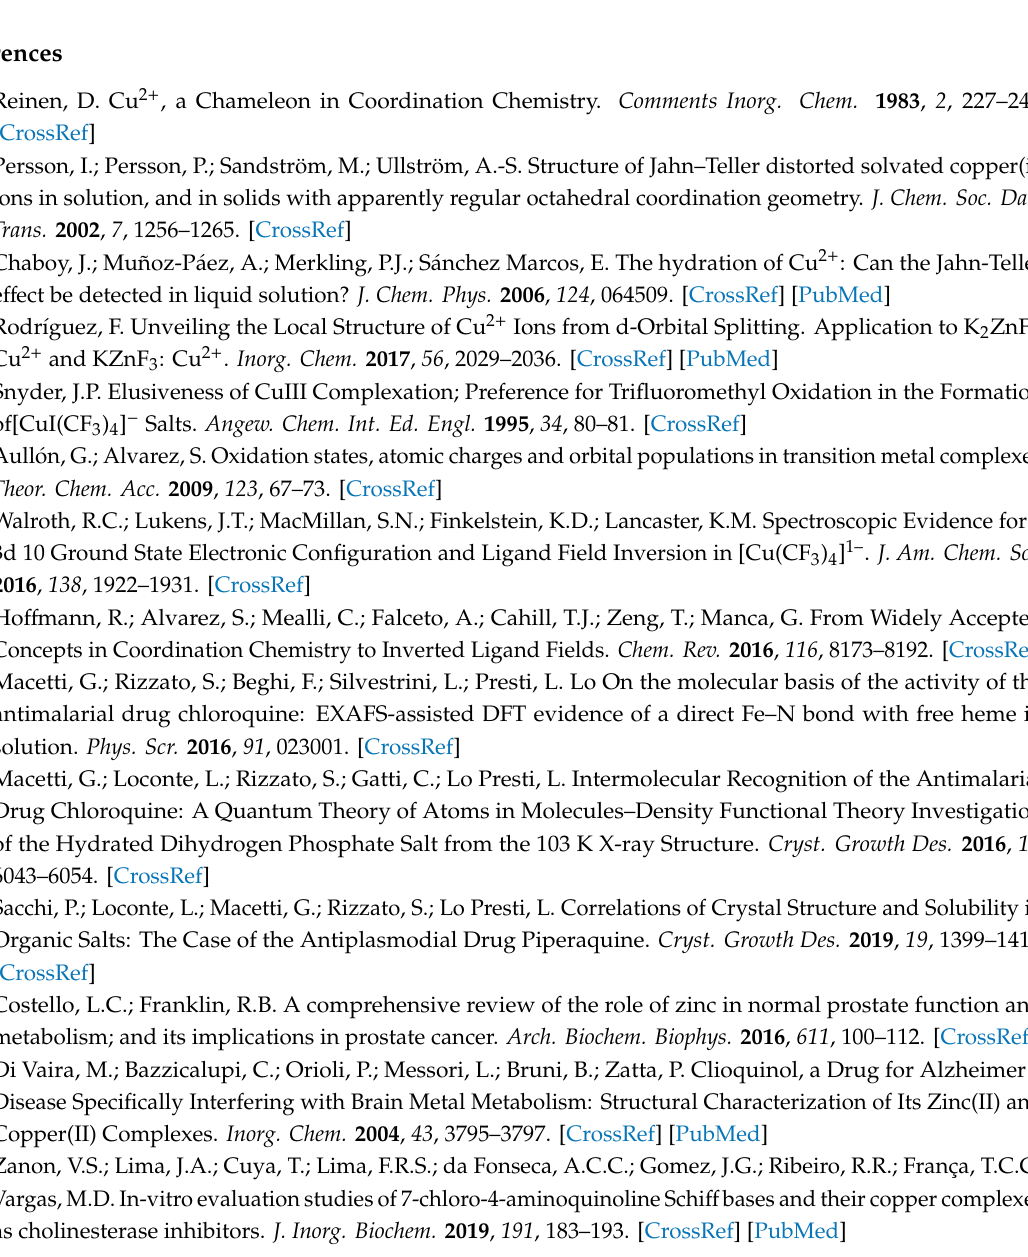
DFT–optimized geometries. Figure S12: Topological molecular graph. Figure S13: Frontier orbitals. Table S1: Least–squares results. Table 1: Agreement factors. Coordinates and Uiso at 100 K. Table S3: Harmonic Halogen ··· hydrogen contacts. Table S11: Halogen–bonded interactions. Table S12: Stacking distances. Table S13: Coordination geometries. Tables S14 and S15: DFT–optimized coordinates. Tables S16 and S17: Relevant bcp properties. Table S18: Bond lengths in aromatic rings. Table S19: Magnetic data. Table S20: Pascal shielding constants. Table S21: Mulliken